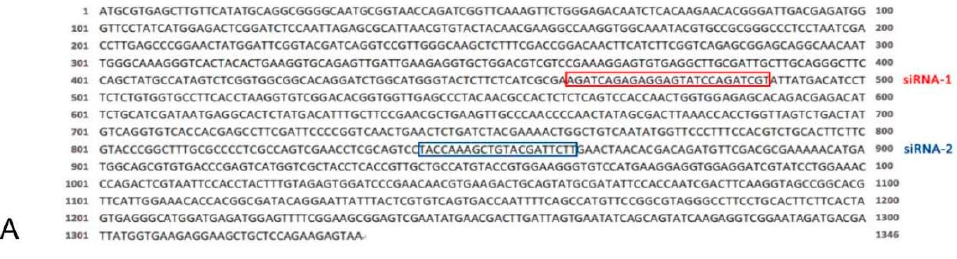
Figure 1. siRNA targeting EmTUBB3. ( A ) Sequence of EmTUBB3 and target sites of siRNA ‐ 1 and siRNA ‐ 2. ( B ) Relative expression of TUBB3 in E. multilocularis PSCs treated with siRNA ‐ 1 and siRNA ‐ 2 at different time points. * p ‐ value < 0.05, ** p ‐ value < 0.01. 3.2. Viability of and Morphological Changes in PSCs Treated with siRNA ‐ 1 and siRNA ‐ 2 As shown in Figure 2A, the viability, evagination rates and numbers of contractions in siRNA ‐ treated PSCs were time ‐ dependent. On day 15, compared with those in the neg ‐ ative control group, the viability and evagination rates of siRNA ‐ 1 ‐ and siRNA ‐ 2 ‐ treated PSCs decreased to 60% and 55% ( p ‐ value < 0.01) and 52% and 50% ( p ‐ value < 0.01), respec ‐ tively. In addition, the numbers of body contractions in siRNA ‐ 1 ‐ and siRNA ‐ 2 ‐ treated PSCs were reduced to five and four contractions per minute, compared with nine contrac ‐ tions in the controls, respectively ( p ‐ value < 0.01). The changes in the siRNA ‐ treated PSCs, including morphological abnormalities such as irregular tegument shrinkage, roughness and shedding of axe ‐ shaped hooks, were found to occur mainly in the tegument surface (Figure 2B, c d arrow and g h). However, these phenomena were not observed in the un ‐ treated controls, which had a smooth outer surface (Figure 2B(a,e)). Ultrastructural changes in the flame cells of the E. multilocularis PSCs treated with siRNA ‐ 1 and siRNA ‐ 2 are shown in Figure 2C. In particular, in both siRNA ‐ 1 ‐ and siRNA ‐ 2 ‐ treated PSCs, the structures of the cilia enclosed in the cell body were cracked, with empty internal cavities in the cytoplasm of the flame cell and ruptures of the microtubule structures (Figure 2C, k l arrows). In addition, siRNA ‐ 2 ‐ treated PSCs were lacking a cell membrane in the flame cell structure (Figure 2C, l arrows).